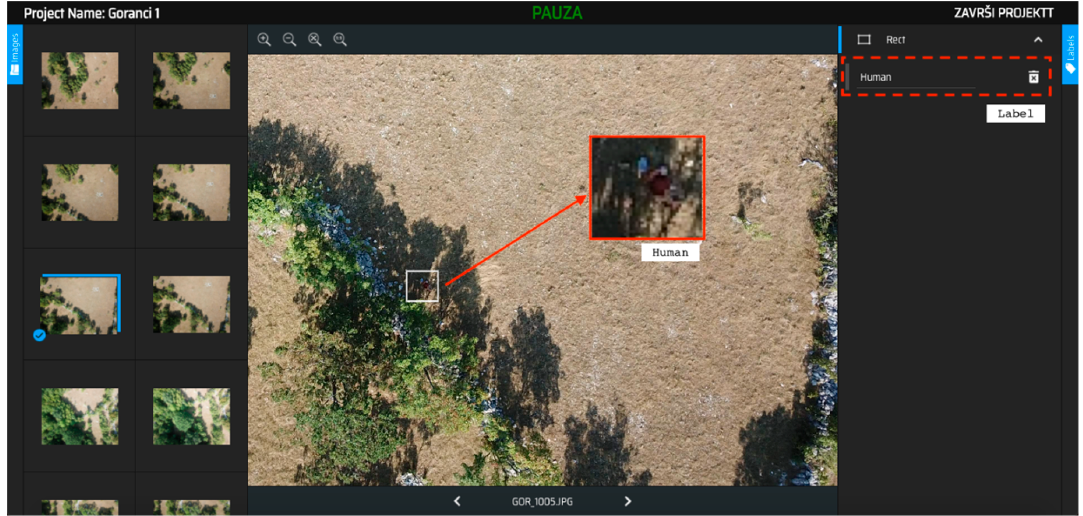
Figure 9. Main screen of the developed web application for detection accuracy comparison between the expert and the ScoreMap to ROI algorithm.